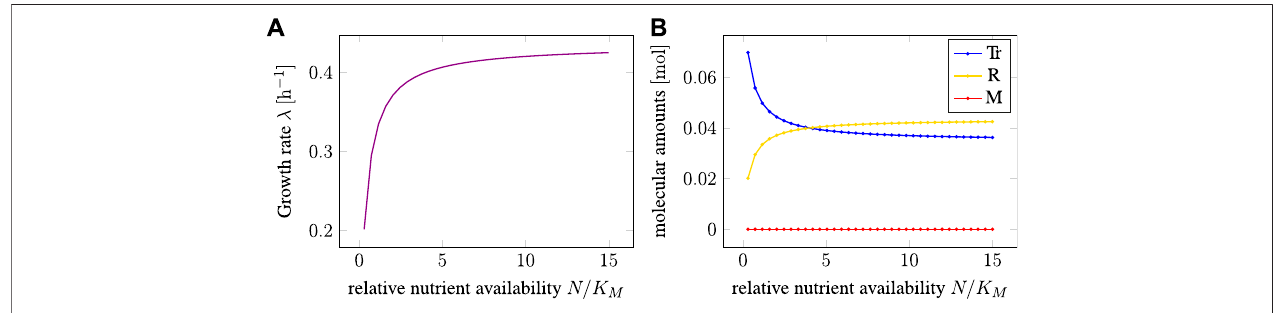
FIGURE 2 | (A) Maximal growth rate λ as a function of the (relative) extracellular nutrient availability as predicted by RBA. (B) Cellular amounts of intracellular compounds as functions of relative nutrient availability. Extracellular nutrient is measured relative to the Michaelis constant K M of the uptake reaction.